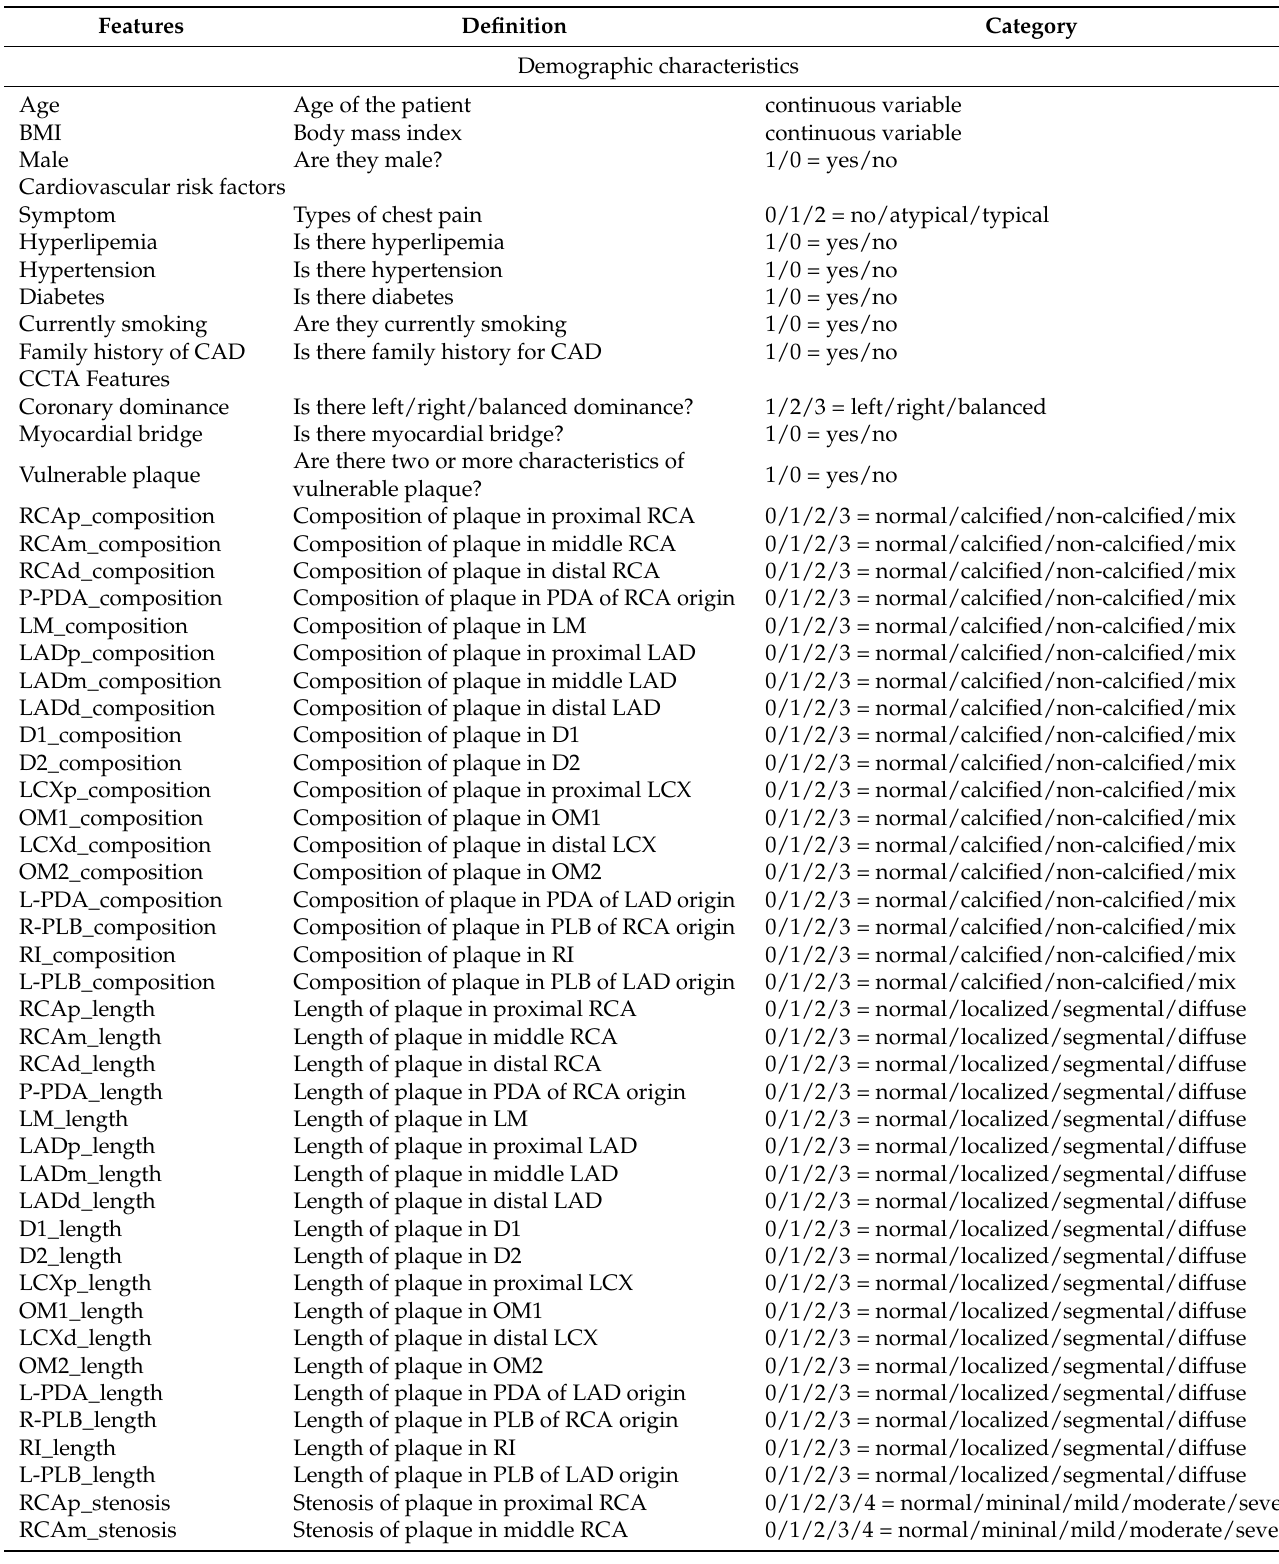
Table 1. Features Selected by